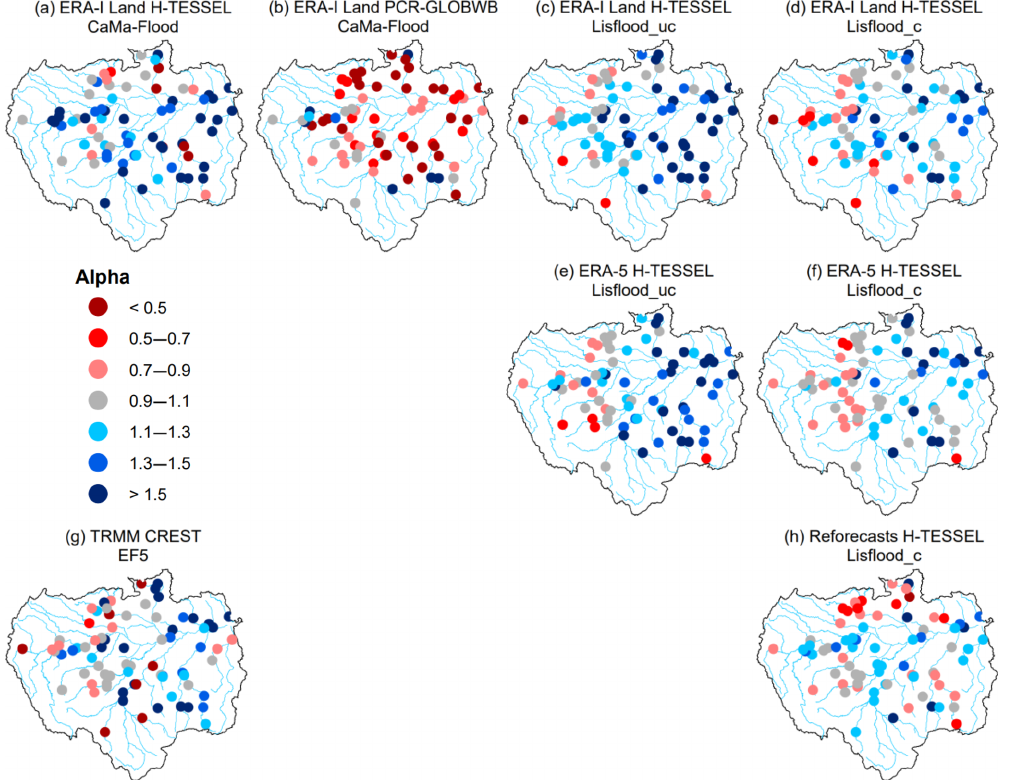
Figure 4. Alpha (i.e. variability ratio) component of the KGE at the 75 hydrological gauging stations for all the simulations. For the periods 1997–2015 and 2004–2015 for the Coupled Routing and Excess Storage, Ensemble Framework for Flash Flood Forecasting (CREST EF5) run (g). Blue circles indicate that the variability in the simulated time series is higher than that of the observed one, while red circles show the opposite effect. Values closer to one indicate better model performance (i.e. grey